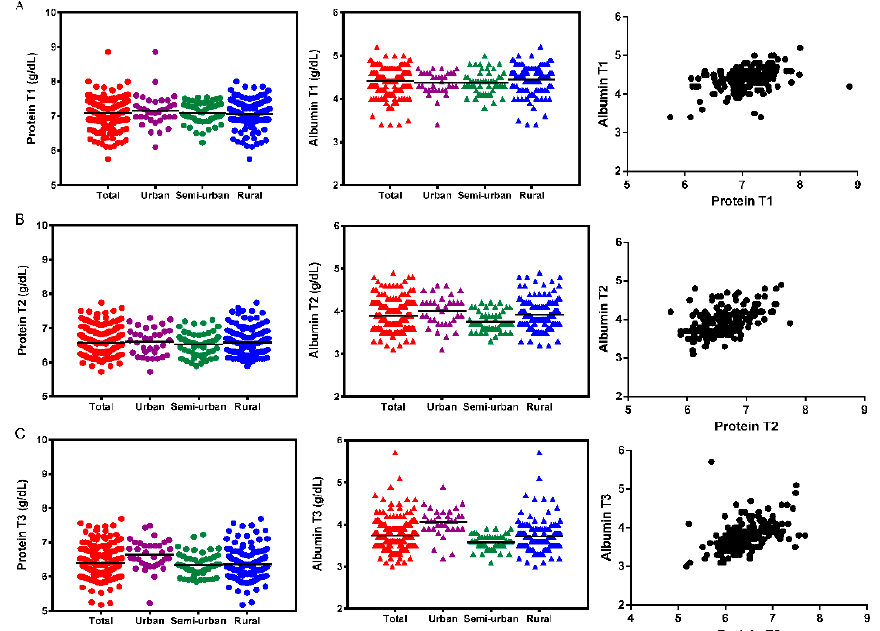
Figure 1. Levels of plasma total protein and albumin among pregnant women at T1 ( A ), T2 ( B ), and T3 ( C ) trimesters of pregnancy. Left panel: plasma total protein level; middle panel: plasma albumin level; right panel: correlation between plasma total protein and albumin levels in the total population (T1: Spearman’s Rho, ρ = 0.457, P = 0.000; T2: ρ = 0.543, P = 0.000; T3: ρ = 0.539, P = 0.000).